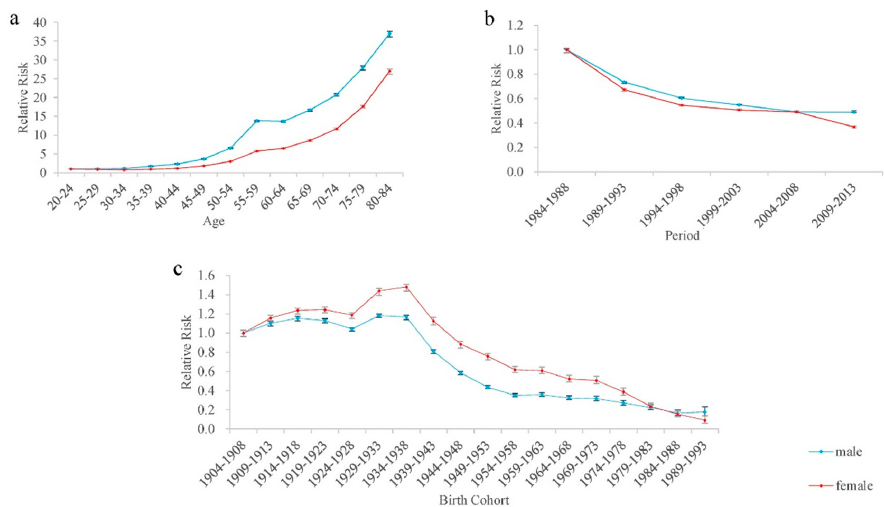
Figure 3. The relative risk and 95% confidence intervals of age, period, and cohort effects of all-cause mortality risk among Macheng City residents, 1984–2013. ( a ) The relative risk and 95% confidence intervals of age effects of all-cause mortality risk. ( b ) The relative risk and 95% confidence intervals of period effects of all-cause mortality risk. ( c ) The relative risk and 95% confidence intervals of birth cohort effects of all-cause mortality risk. Table 1. APC model analysis results of all-cause and cancer mortality in Macheng.